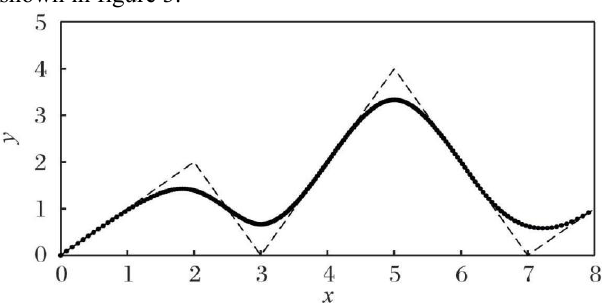
Figure 3. Soothing process. (dotted line: original curve; full line: smoothed